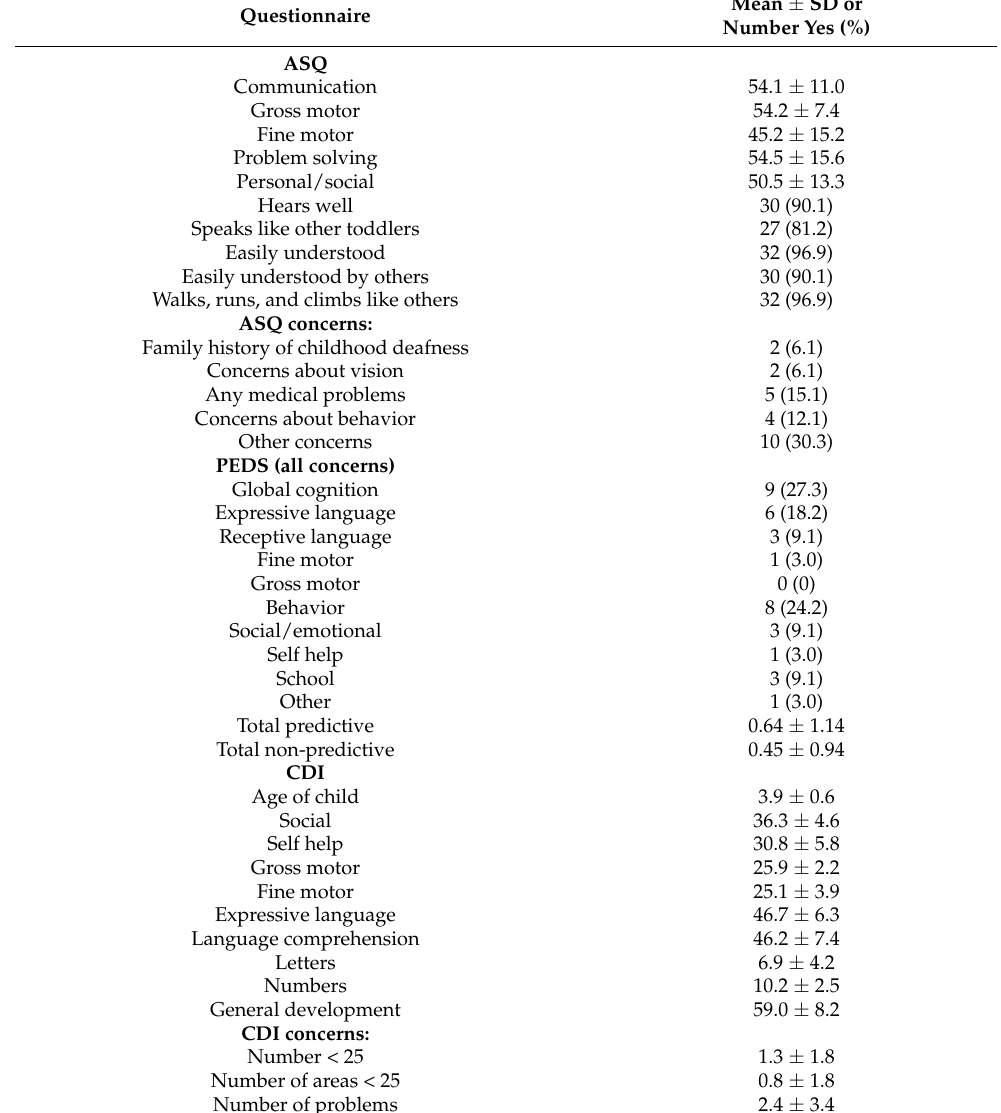
Table A1. Distribution of scores within